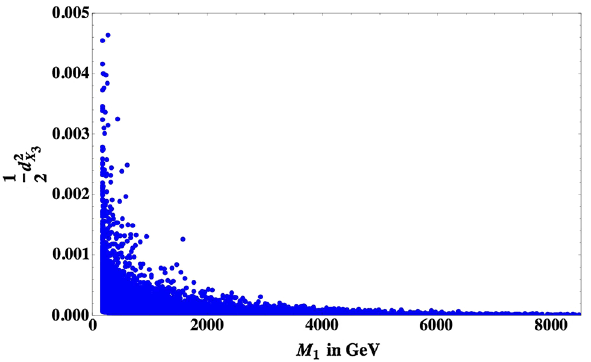
Fig. 3 Maximum deviations from unitarity as a function of M 1 , gen- erated under the condition that Tr ( mm † ) ≤ m 2 t and | η 12 | ≤ 2 × 10 − 5